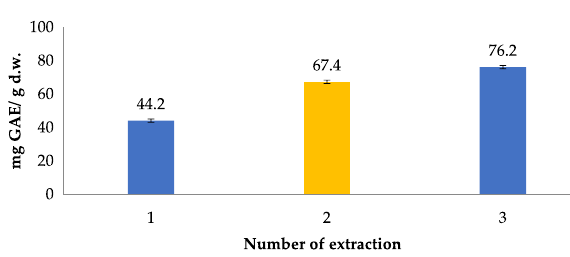
Figure 5: Polyphenol extraction a ff ected by number of extraction ( Operating conditions: ethanol concentration of 70% ( v/v ) ; tem - perature of 60°C; material – solvent ratio of 1:8 g/mL; and operating time 15 min ) .